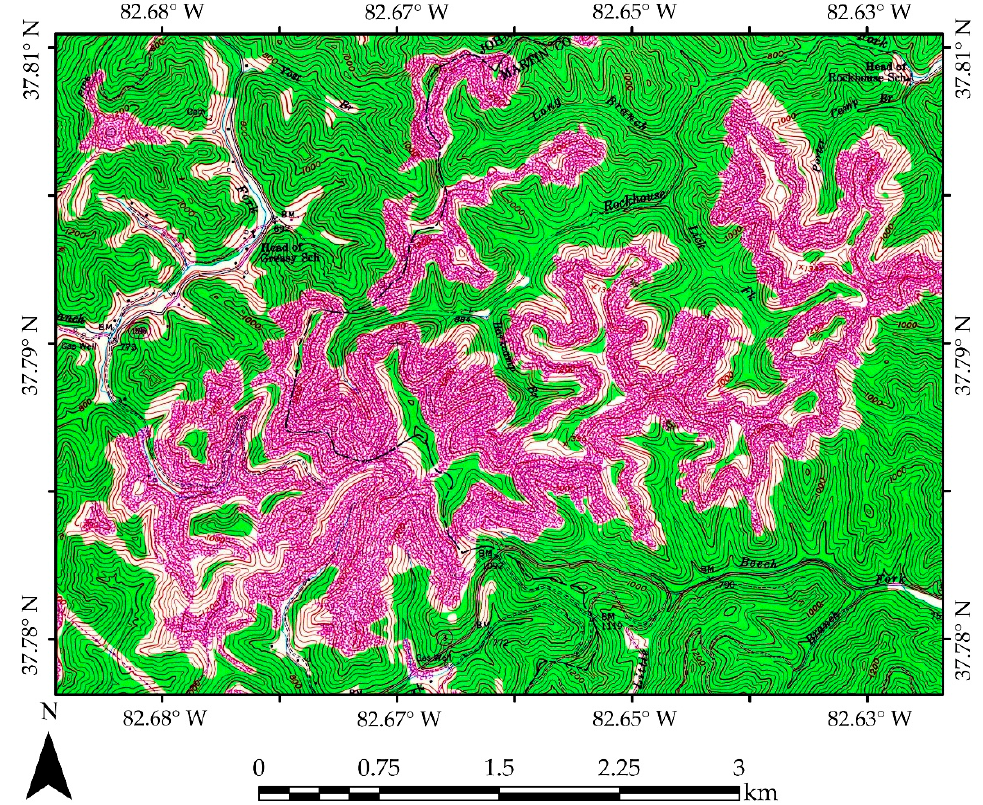
Figure 1. Example of surface mine features as represented on part of a historic topographic map (Quad = Offutt, State = Kentucky (KY), Year = 1954, SCANID = 709431). Topographic map obtained from the United States Geological Survey (USGS) and the National Map’s Historical Topographic Map Collection.